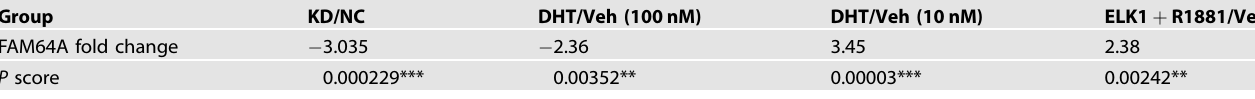
Table 5. The effect of different concentrations of DHT on the expression of FAM64A.